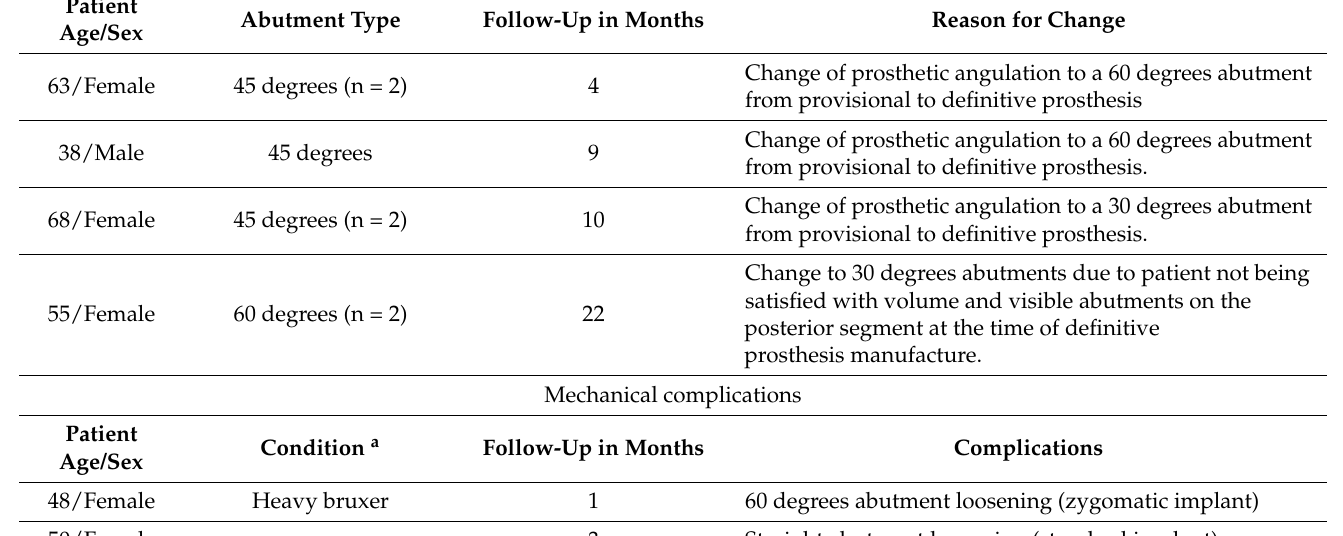
Table 3. Replacement of study abutments and incidence of mechanical